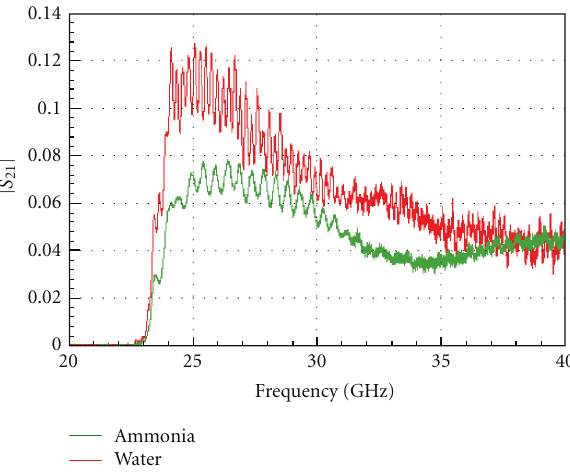
Figure 3: Transmission measurements of water-only and water- ammonia liquid